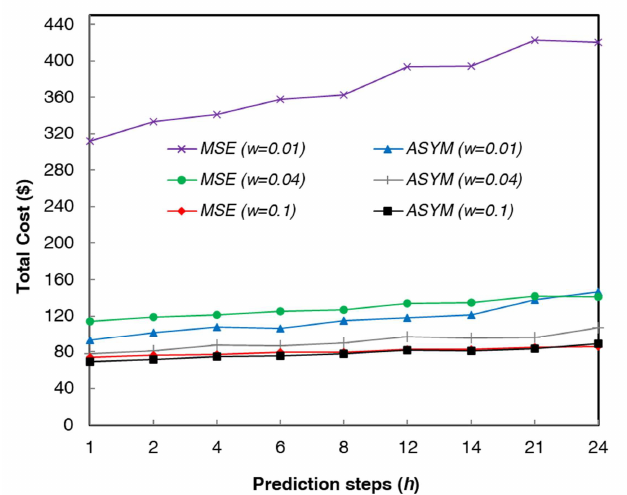
Figure 7. Total cost in allocating resources for the NFV network of Figure 4 as a function of the prediction step h and when w varies from 0.01 to 1. The results are reported for the MSE and ASYM LSTM prediction